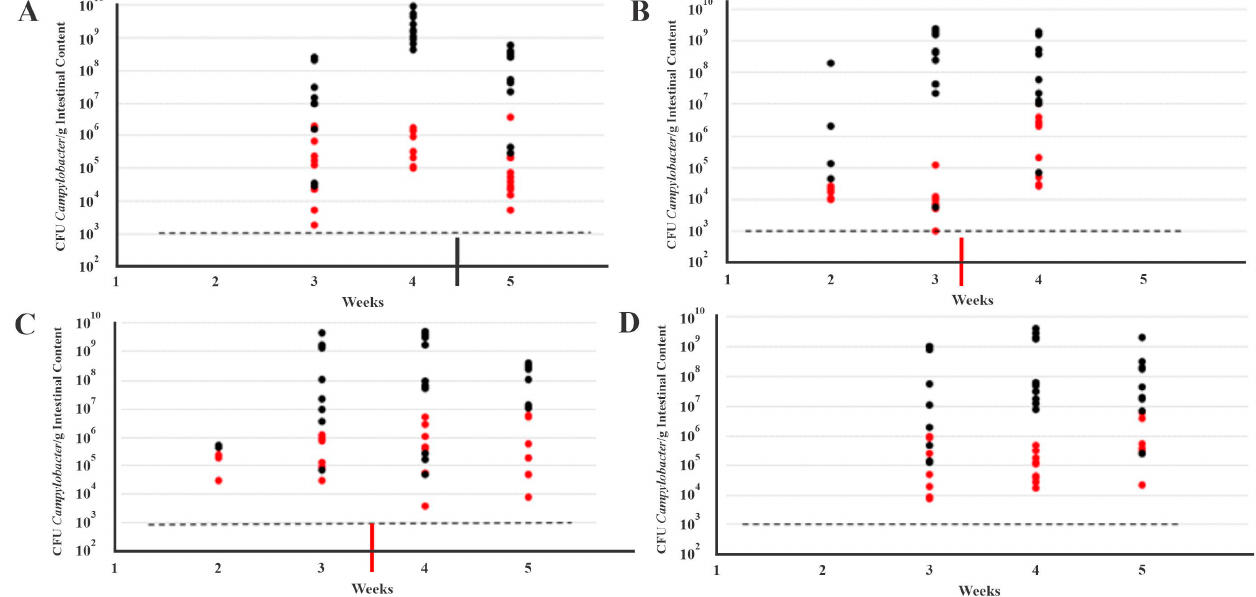
Figure 1. Campylobacter load within the cecum and jejunum from the four turkey flocks. The average Campylobacter load of the ten sampled birds from ( A ) flock 1, ( B ) 2, ( C ) 3, and ( D ) 4 are shown for each time point starting with week 1. Red and black dots represent CFU/g counts from the jejunum and cecum, respectively. A thick black line and a thick red line along the x axis indicate the time of administration of copper sulfate and penicillin/gentamicin, respectively. The limit of detection (horizontal black dotted lines) was 1.00 × 10 3 CFU/g in the cecum and 1.00 × 10 1 CFU/g in the jejunum.